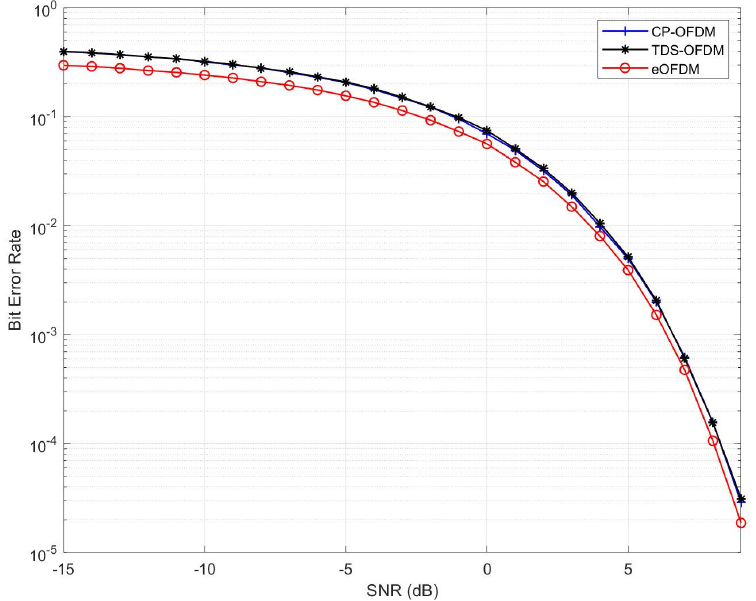
Figure 5. BER comparison of CP-OFDM, TDS-OFDM and eOFDM in AWGN